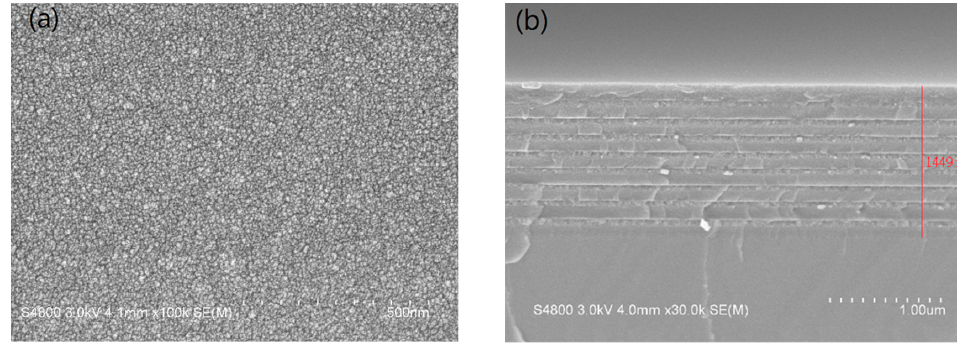
Figure 7. SEM micro–images of the notch filter ( a ) top view; ( b ) cross–section